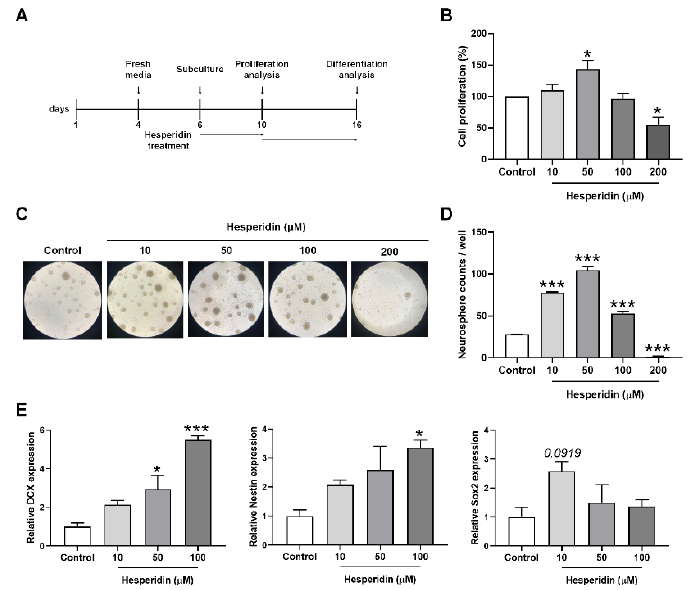
Figure 1. The effects of hesperidin on cell proliferation in neural stem cells isolated from mouse embryonic brain. ( A ) In vitro neurosphere culture and experiment scheme. Cells were pretreated with 10, 50, 100, and 200 µM hesperidin for 4 days. ( B ) Cell proliferation (%) was measured using a WST-1 assay. ( C , D ) Representative images showing proliferation and the number of neurospheres of at least 100 µm in the graph. ( E ) Neural stem cell-specific proliferation was confirmed by measuring the mRNA levels of DCX, nestin, and Sox2 by qRT-PCR. Statistical analysis included one-way analysis of variance and Tukey’s post hoc test. * p < 0.05 and *** p < 0.001 compared with the vehicle-treated control group. Data are shown as mean ± SEM ( n = 3 per group).